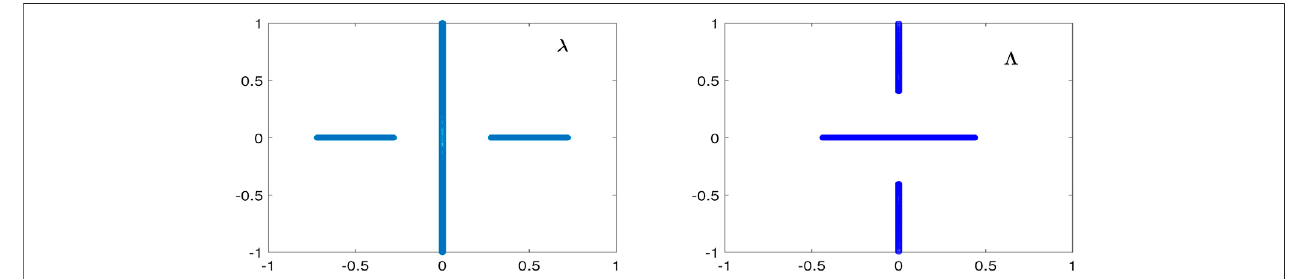
FIGURE 2 | Lax spectrum on the λ -plane (left) and stability spectrum on the Λ -plane (right) for the dn-periodic wave Eq. 2.11 with k (cid:2) 0 . 9.